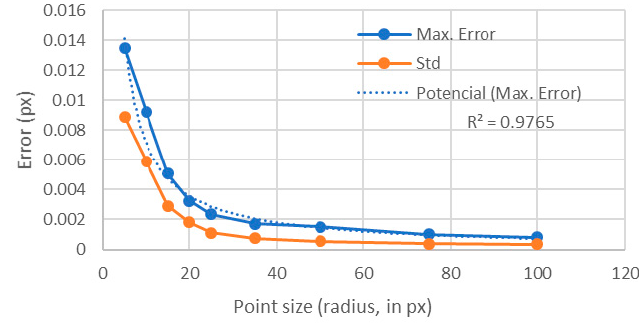
Figure 7. Influence of the point size when the area ratio was set to 1.